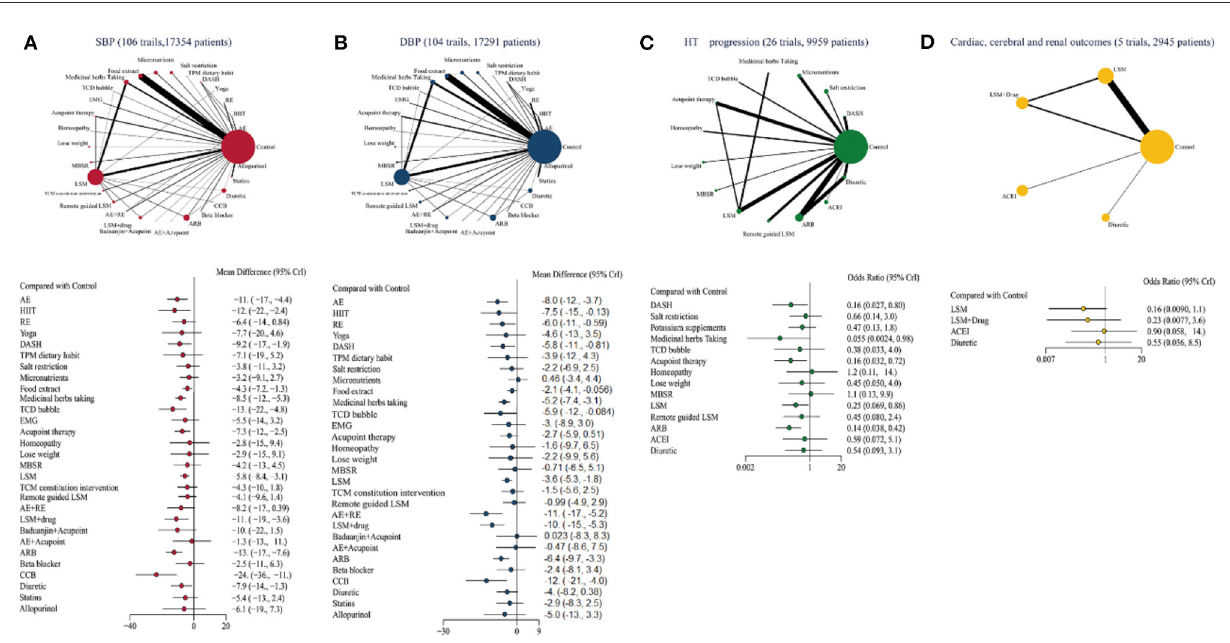
FIGURE2 Network geometry and forest plot in PHT with four outcomes. (A) SBP (106 trails, 17,354 patients), (B) DBP (104 trails, 17,291 patients), (C) HT progression (26 trails, 9,959 patients), (D) Cardiac, cerebral, renal, and mortality outcomes (five trails, 2,945 patients). The difference among each comparison is visualized with forest plot, and the effect size is labeled on the right-hand side. AE, aerobic exercise; HIIT, high-intensity interval training; RE, resistance exercise; DASH, dietary approaches to stop hypertension; TPM, Traditional Persian Medicine; TCD, traditional Chinese drug; EMG, electromyographic; MBSR, mindfulness-based stress reduction; LSM, lifestyle modification; TCM, Traditional Chinese Medicine; ARB, angiotensin II receptor blockers; ACE, angiotensin-converting enzyme inhibitors; CCB, calcium channel